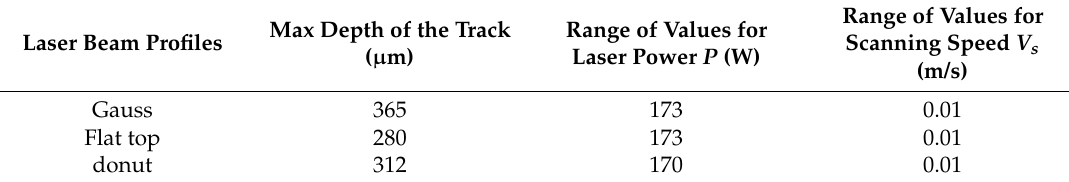
Figure 10. Dependence of single track depth D (µm) on process parameters for CoCrMo powder: ( a ) bar graph for Gauss; ( b ) 3D graph for Gauss; ( c ) bar graph for flat top; ( d ) 3D graph for flat top; ( e ) bar graph for donut; ( f ) 3D graph for donut; an absence of metallurgical contact or not formed track during processing is marked as “0”. Table 4. The maximum values of the depth for each profile during SLM production of single tracks from CoCrMo powder with the height of the layer ~80 µm.